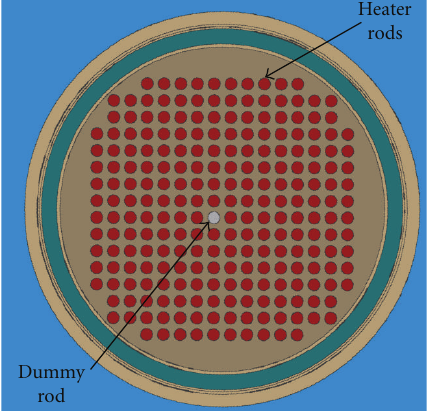
Figure 6: SPES3 heater rod bundle.